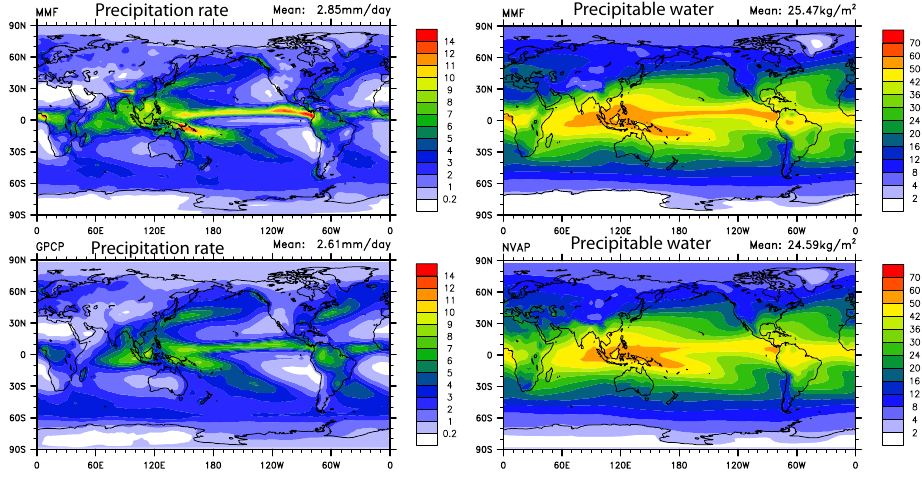
Fig. 5. PD annual average precipitation rate (left panels) and precipitable water (right panels) from the MMF model (upper panels) and from the observations (lower panels: precipitation rate from the GPCP observations and precipitable water from the NVAP